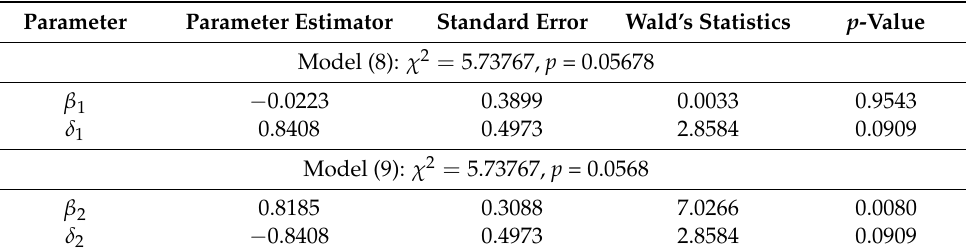
Table 3. Parameter estimation results for Cox regression